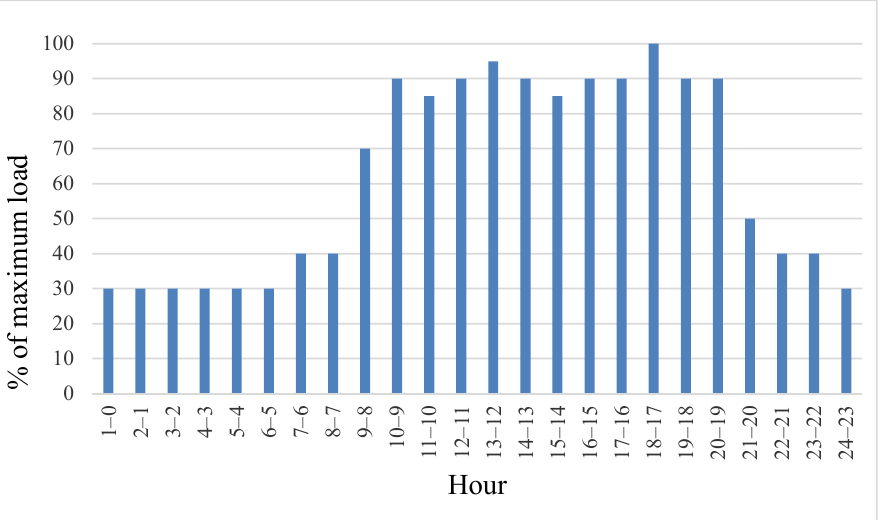
Figure 4. Load curve for commercial sector electricity consumption for a weekday in January 2019 (percentage of the sectoral maximum load). Source: own elaboration with the model [27]. Data on solar radiation and wind are obtained from The Modern-Era Retrospective analysis version 2 (MERRA 2) databases [28,29] and are shown in Figures 5 and 6.